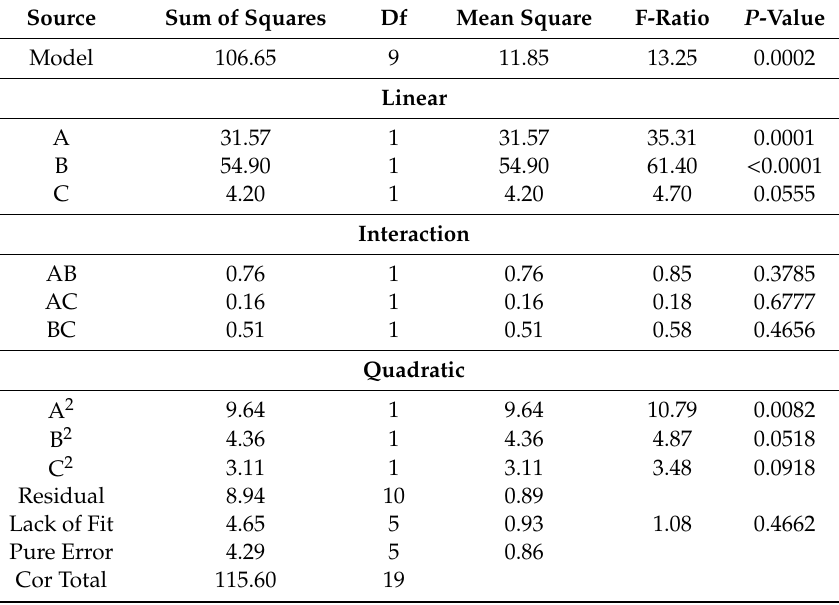
Figure 5. Standardized e ff ect of Pareto chart. A = solid loading, B = extraction temperature and C = extraction time. Table 5. ANOVA statistical analysis for CCD